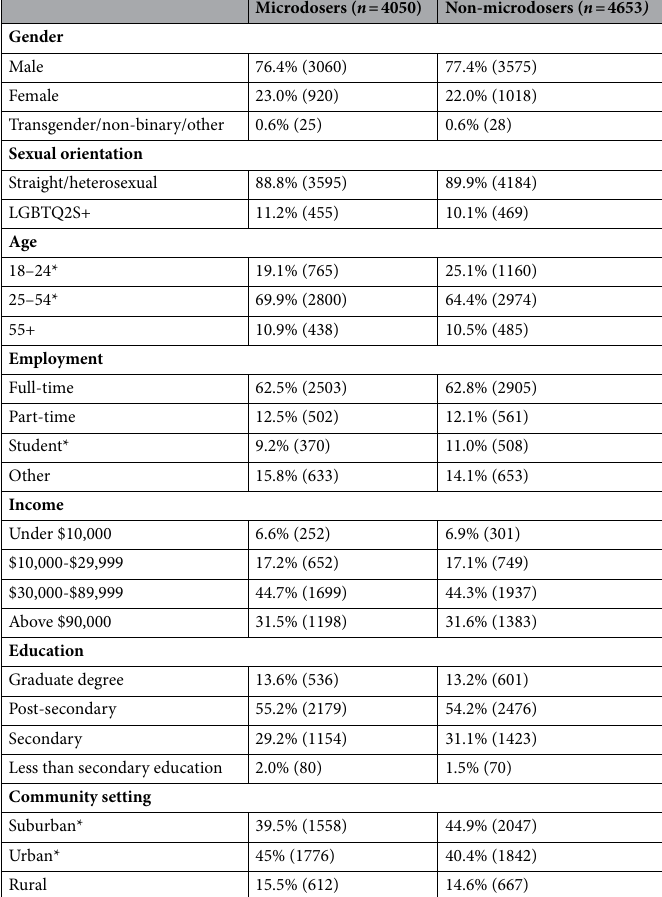
Table 1. Demographic characteristics. On variables with missing data, percentages reflect proportions of the total valid, non-missing, responses within a category. * p <